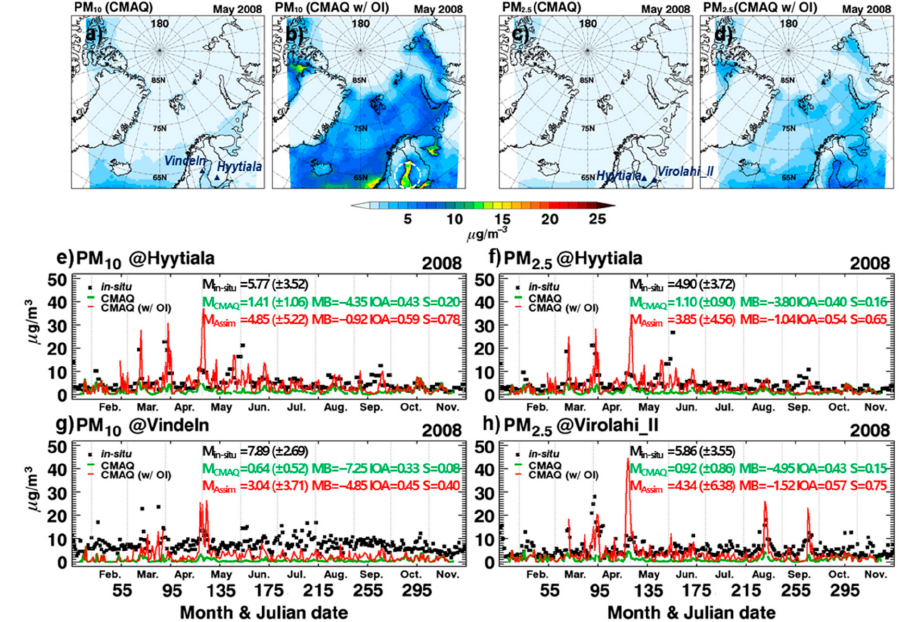
Figure 5. Spatial maps of monthly average PMs calculated from CMAQ simulation and estimated from the linear relationship between assimilated AODs and PMs for May. ( a ) PM 10 and ( c ) PM 2.5 calculated from the CMAQ simulations. ( b ) PM 10 and ( d ) PM 2.5 estimated from the Equations (11) and (12). Daily mean variations of observed (black closed squares), modeled (green lines), and estimated (red lines) PM 10 at ( e ) Hyytiala and ( g ) Vindeln stations and PM 2.5 at ( f ) Hyytiala and ( h ) Virolahi stations. Mean values (M, µ g m − 3 ), mean bias (MB, µ g m − 3 ), Index of Agreement (IOA), and slope (S) from the observation (M in-situ ), CMAQ simulation (M CMAQ ), and linear estimation (M Assim ) for April–September. The closed triangles in Figure (a) and (c) indicate the locations of the monitoring